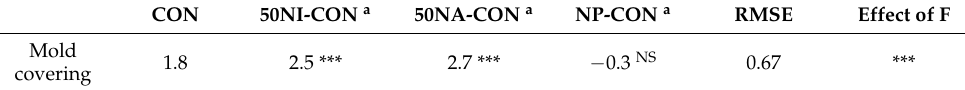
Table 1. Evaluation of mold covering of the sausage surface (visual assessment on a scale 1–5). CON